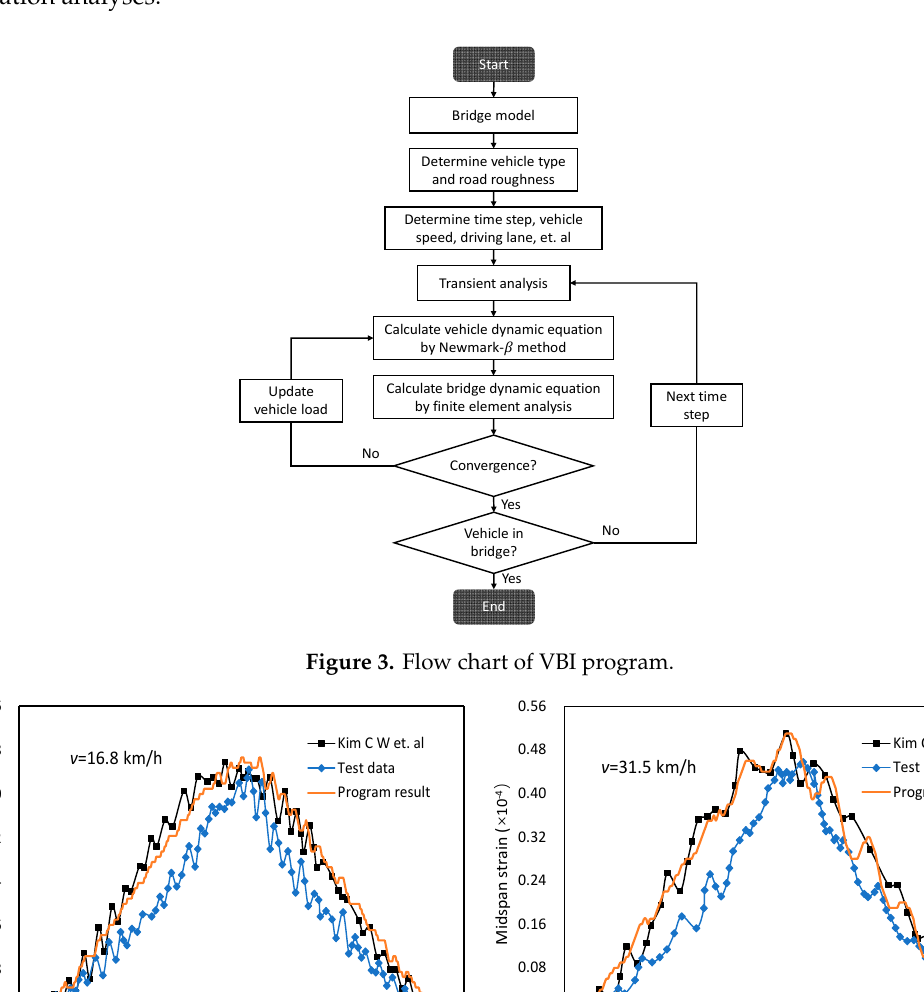
Figure 4. Program verification results of midspan strain. ( a ) v = 16.8 km/h ( b ) v = 31.5 km/h.